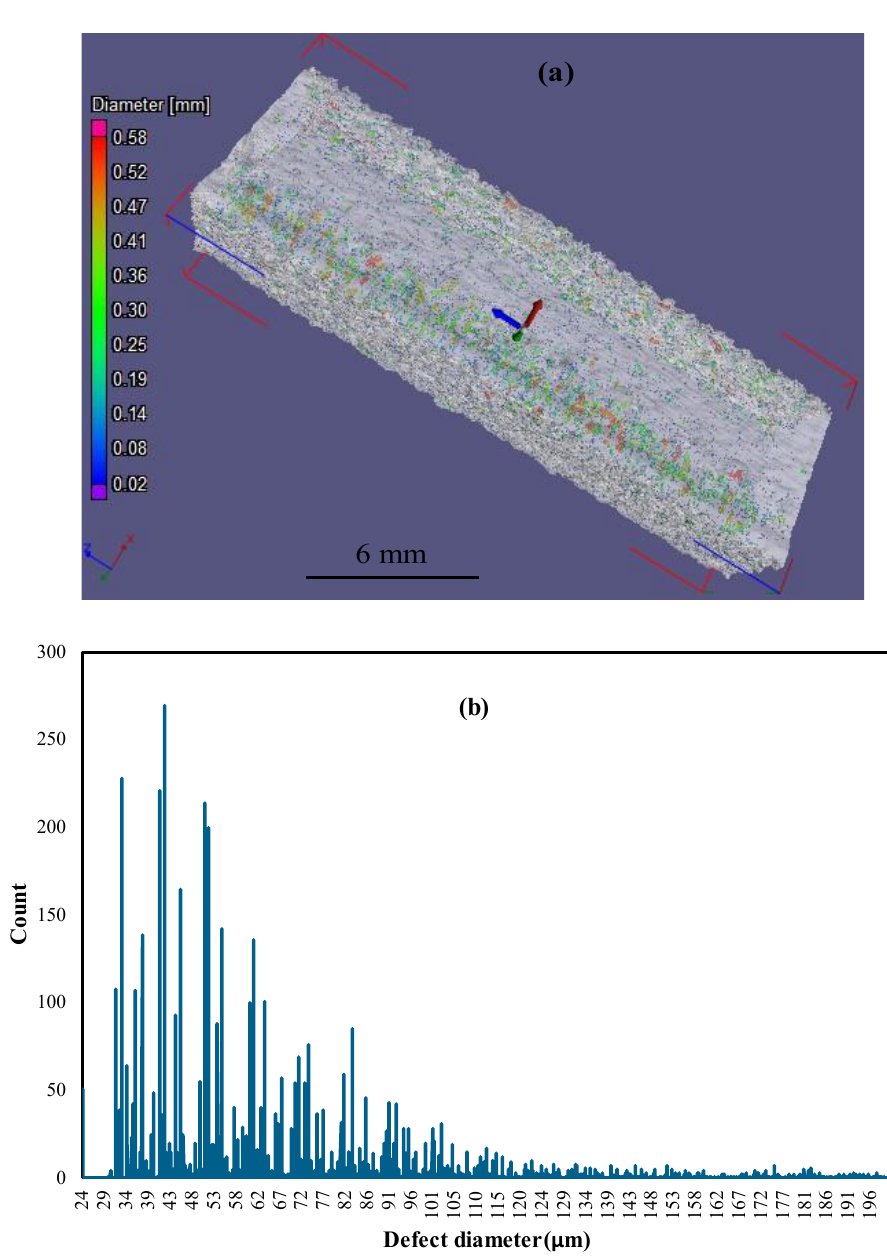
Figure 3. Defect distribution on the flat-built sample, obtained from X-ray CT analysis: ( a ) 3D defect distribution inside the sample, and ( b ) frequencies of the distributed defects.